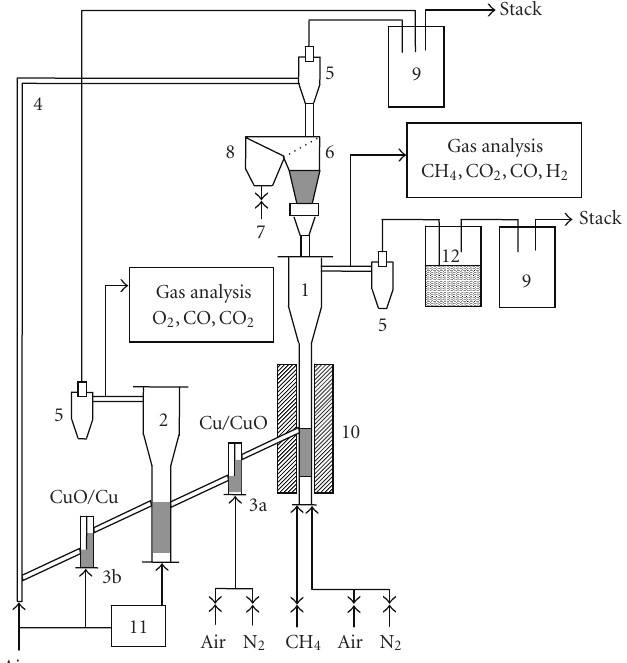
Figure 5: Schematic diagram of the CLC facility of instituto de carboquimica (C.S.I.C.), Spain. (1) fuel reactor, (2) air reactor, (3) loop seals, (4) riser, (5) cyclone, (6) solid reservoir, (7) solids valve, (8) diverting solid valve, (9) filters, (10) oven, (11) air preheater, and (12) water condenser.